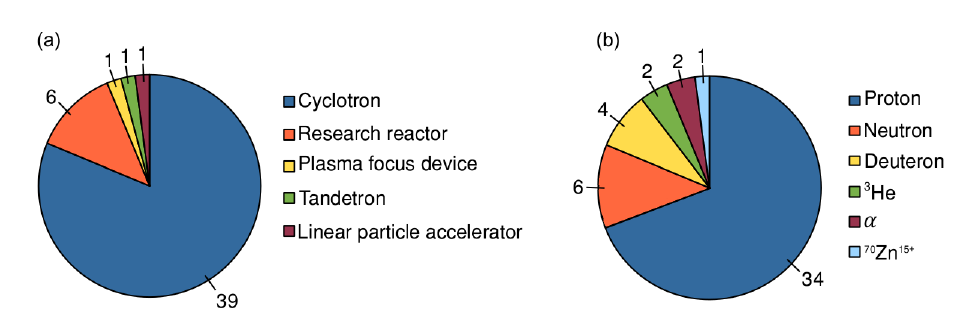
Figure 1. Number of papers that utilized ( a ) the determined production technology and ( b ) acceler- ated particles to produce the intended radioisotope.